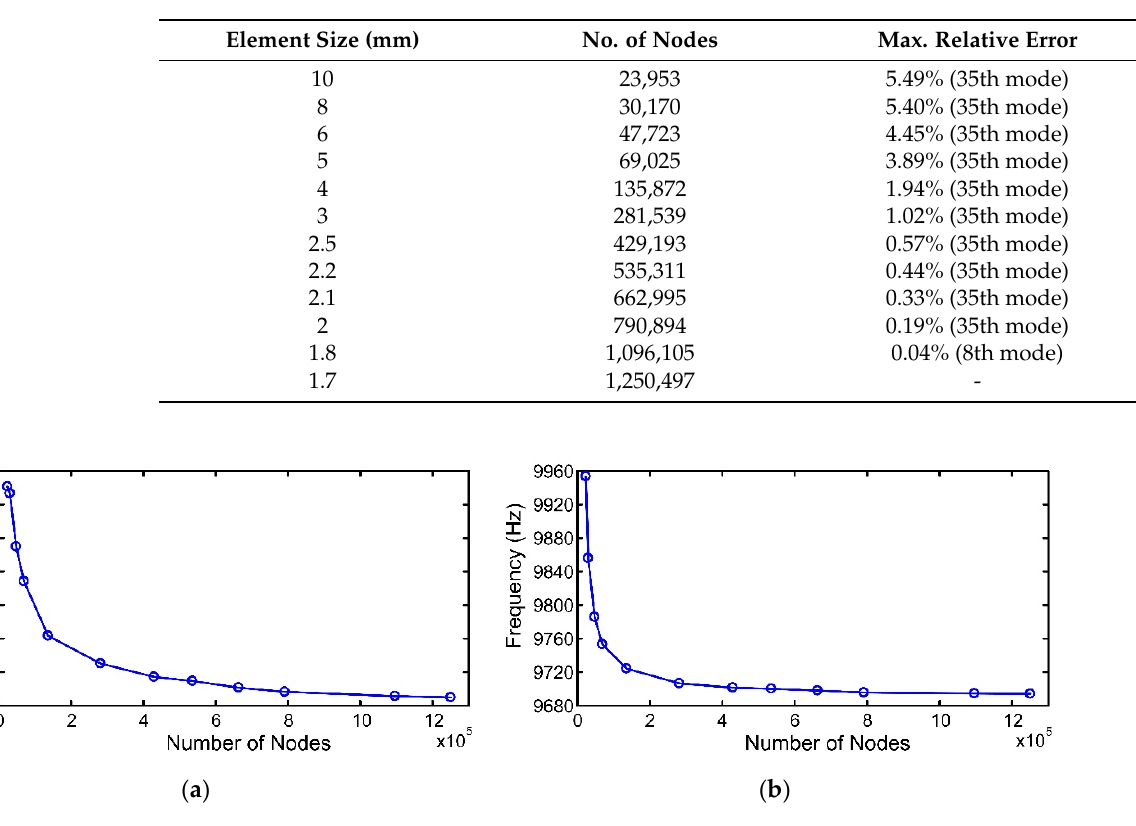
Table 3. Element sizes and numbers of nodes in the model.